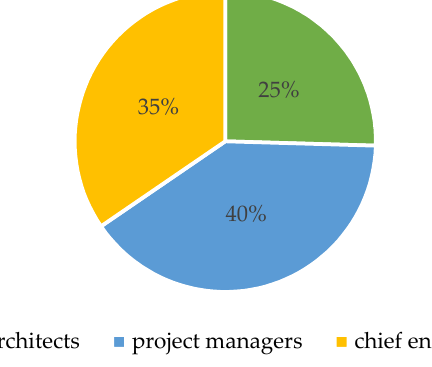
Table 1. Questionnaire survey results.